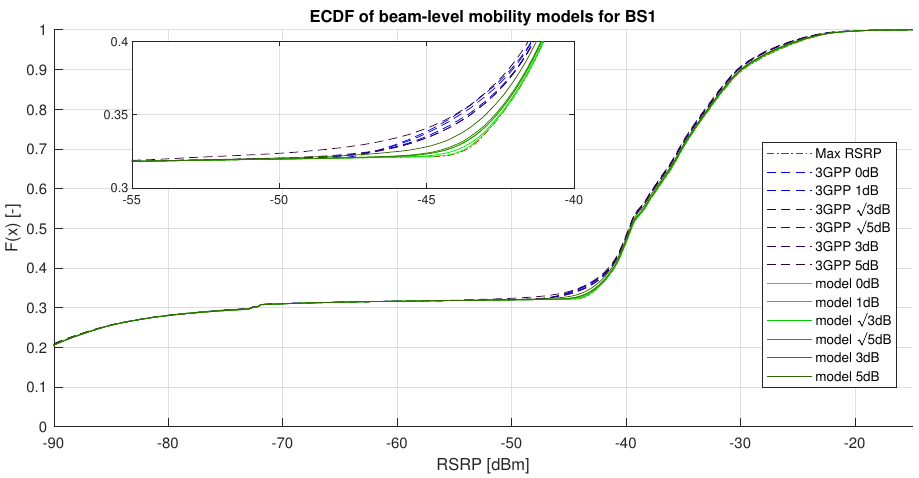
Figure 7. ECDF of beam-level mobility models on BS1 data. Table 4. HO count results for beam-level mobility for BS1 evaluating the performance of benchmark 3GPP model and proposed DL model with different levels of uncertainties present in the input measurements. Model